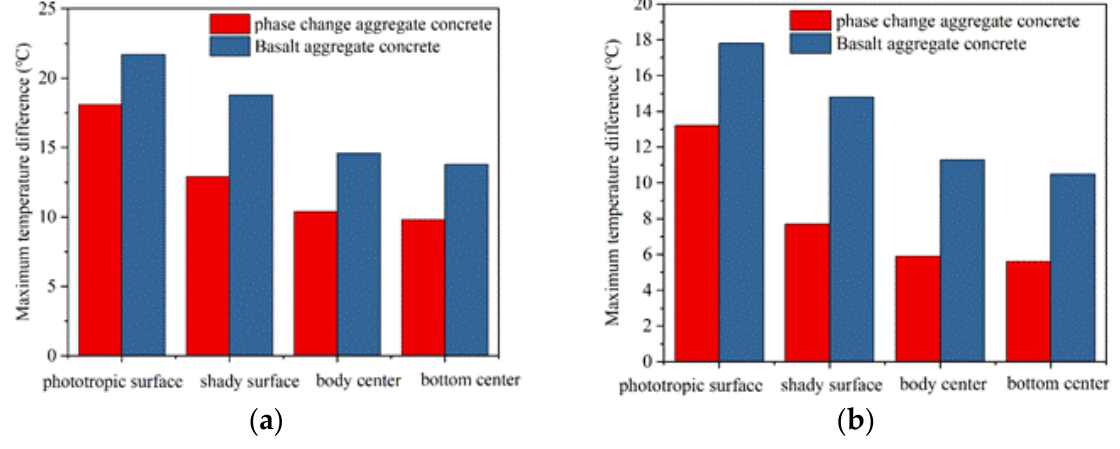
Figure 18. A maximum temperature difference of cube model. ( a ) Heating stage. ( b ) Cooling stage.